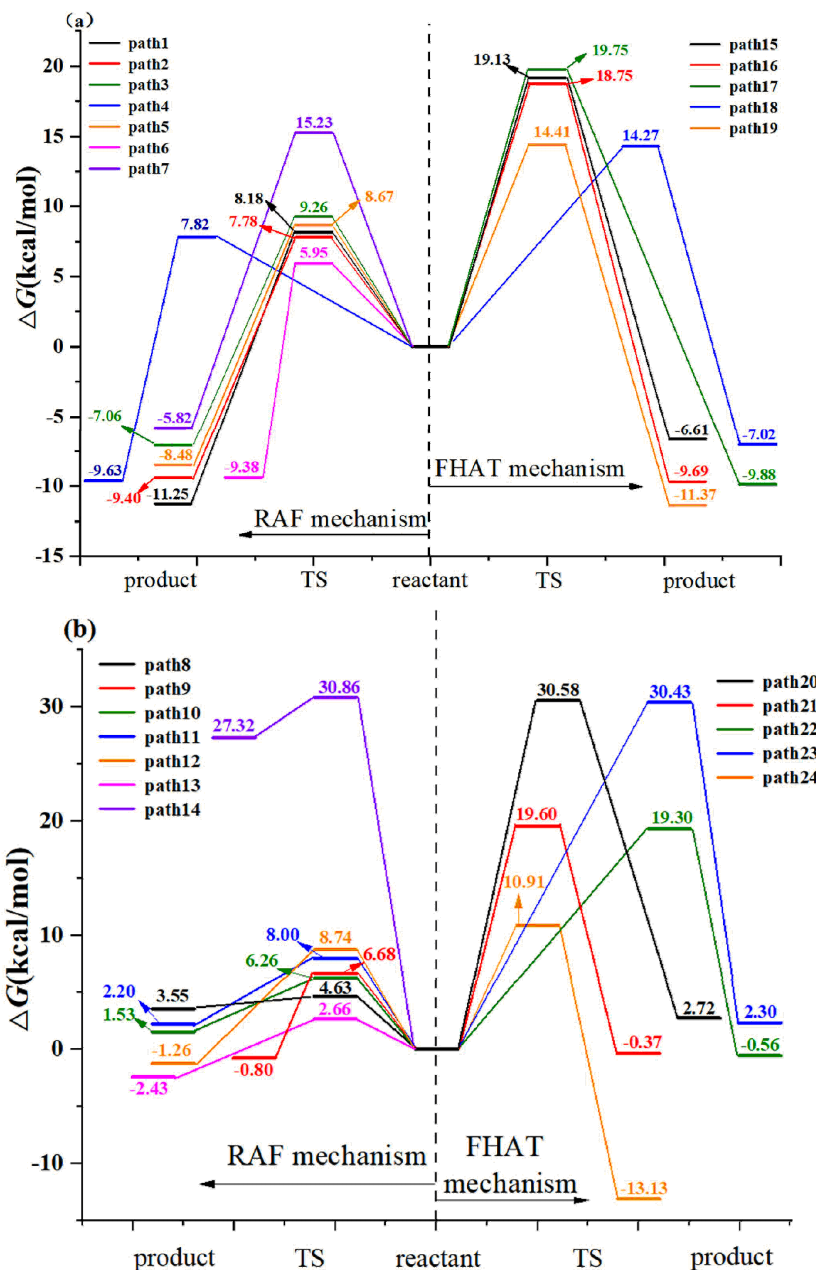
Figure 6. Free energy profiles for FHAT and RAF mechanisms in aqueous phase. ( a ) APP with •OH reactions; ( b ) APP with SO 4 •− reactions.